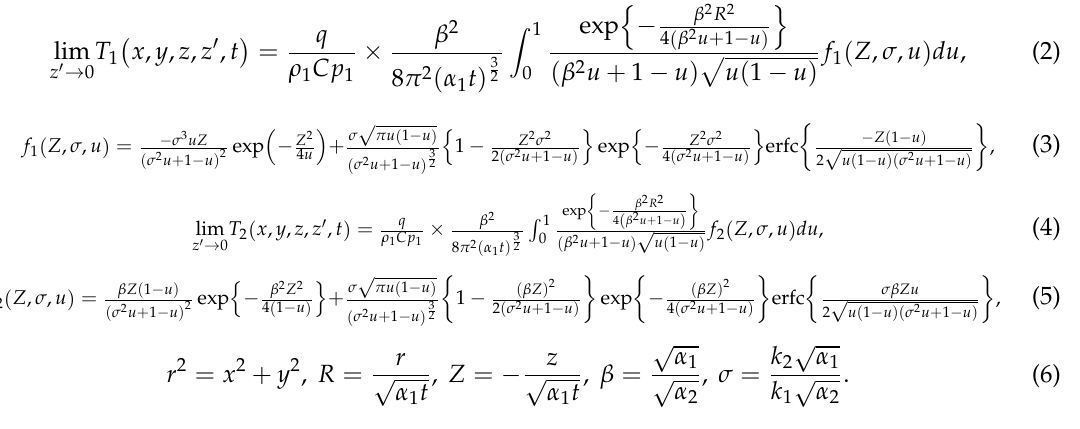
Figure 1. Model for the B.M.W. solution. T (unit: K), temperature; ρ (unit: kg/m 3 ), density; Cp (unit: J/(kg × K)), specific heat capacity; k (unit: W/(m × K)), thermal conductivity; α (unit: m 2 /s), thermal diffusivity; z (cid:48) > 0, position of the point heat source. The subscript designates its domain. The solution can be written as